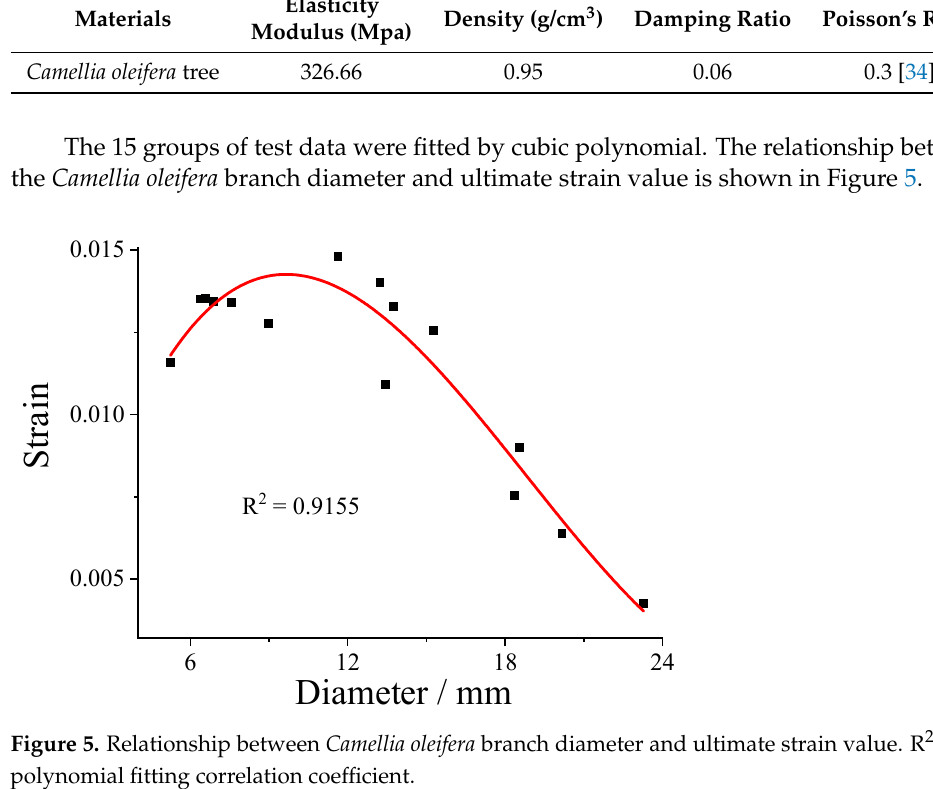
Table 2. Physical characteristics of Camellia oleifera tree.